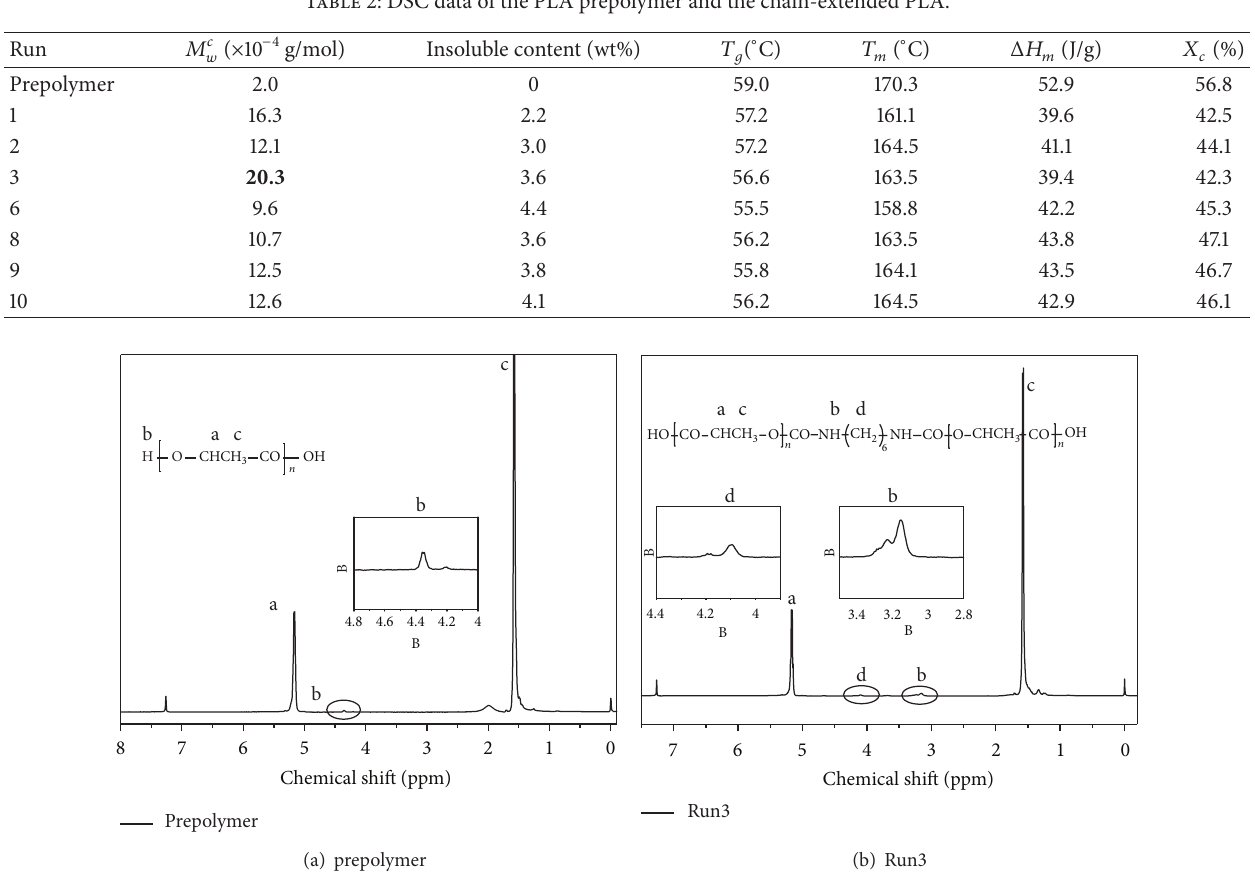
Table 2: DSC data of the PLA prepolymer and the chain-extended PLA.